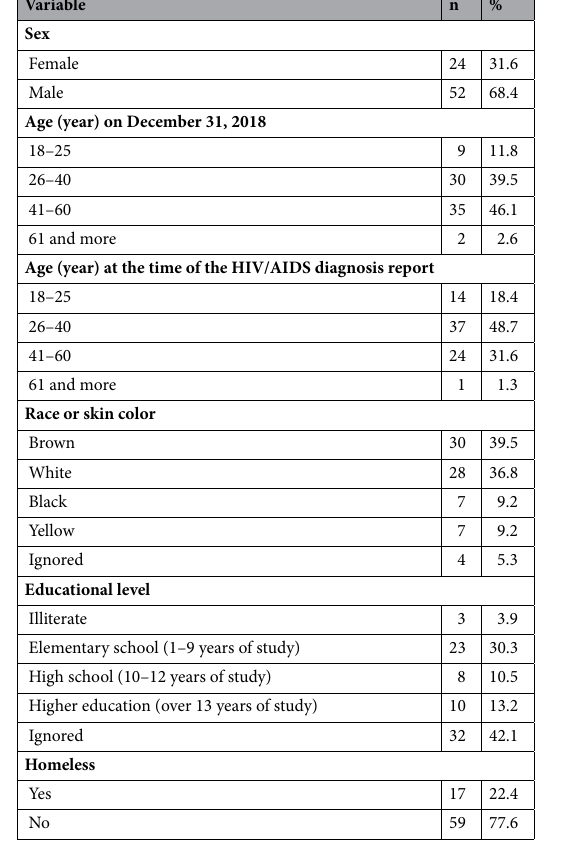
Table 1. Sociodemographic data of the study population ( n = 76). Data source: Notifiable Diseases Information System